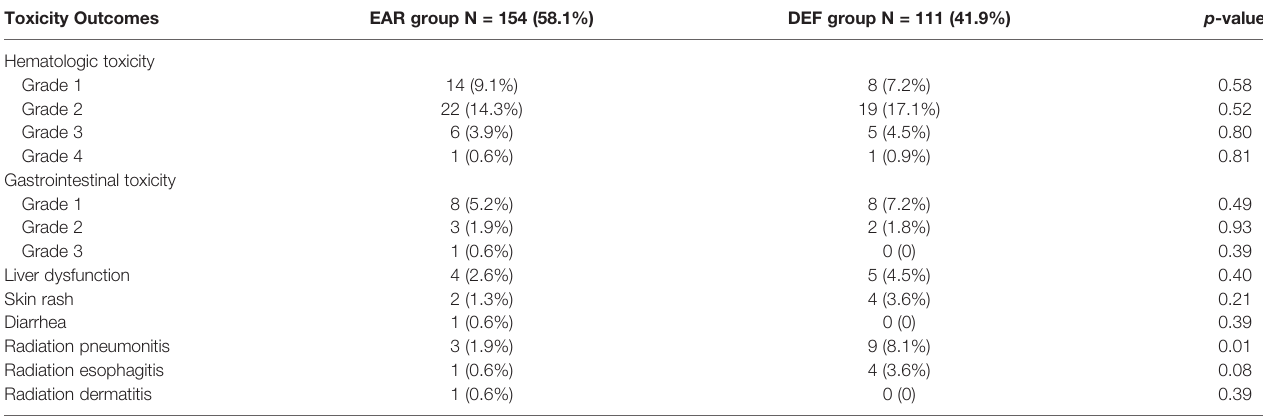
TABLE 4 | Toxicity pro fi le for the EAR and DEF groups. Toxicity Outcomes EAR group N = 154 (58.1%) DEF group N = 111 (41.9%) Hematologic toxicity Grade